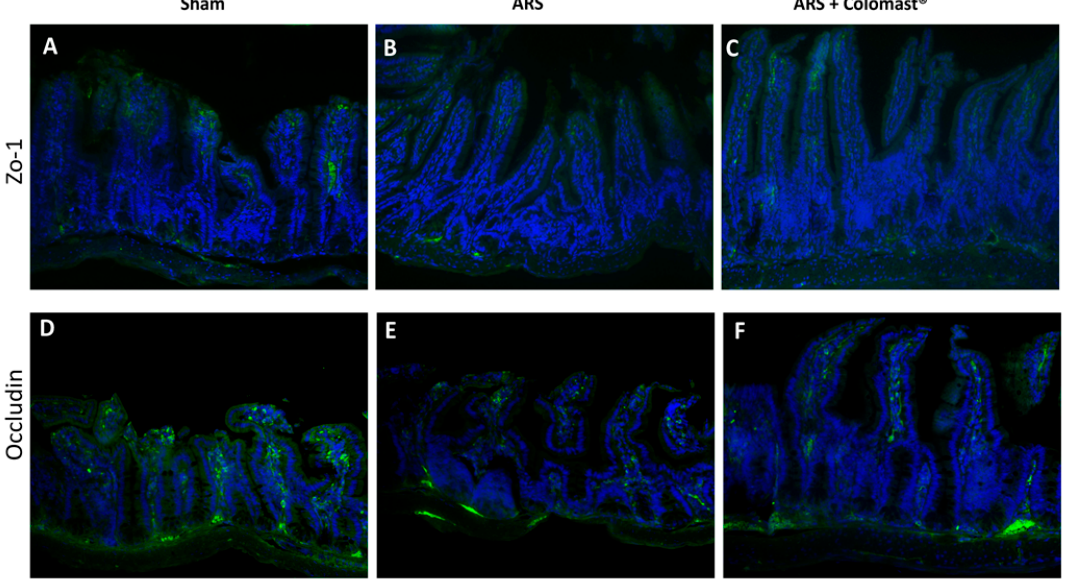
Figure 8. Effect of Colomast ® pre-treatment on tight junction expression in ileum. Immunofluorescence in ileum section of ZO-1 in sham ( A ), ARS ( B ), Colomast ® ( C ), and Occludin in sham ( D ), ARS ( E ), and Colomast ® ( F ). Images are figurative of at least three independent experiments. Values shown are means ± SEM of six animals in each group. For the immunofluorescence, a 20× magnification is shown (100-µm scale bar).